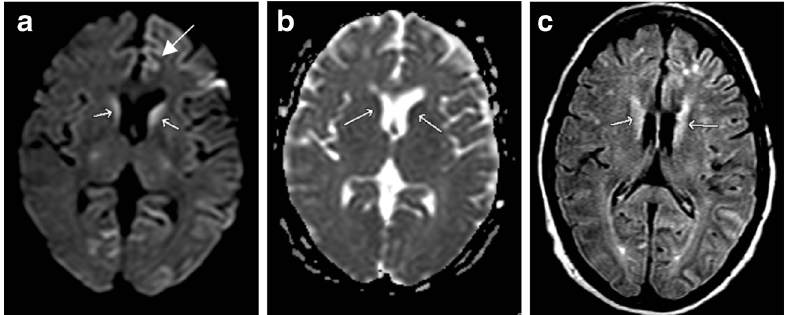
ADC ( b ) demonstrates corresponding low signal within the caudate heads ( small arrows ). FLAIR ( c ) illustrates corresponding increased signal within the caudate heads ( small arrows